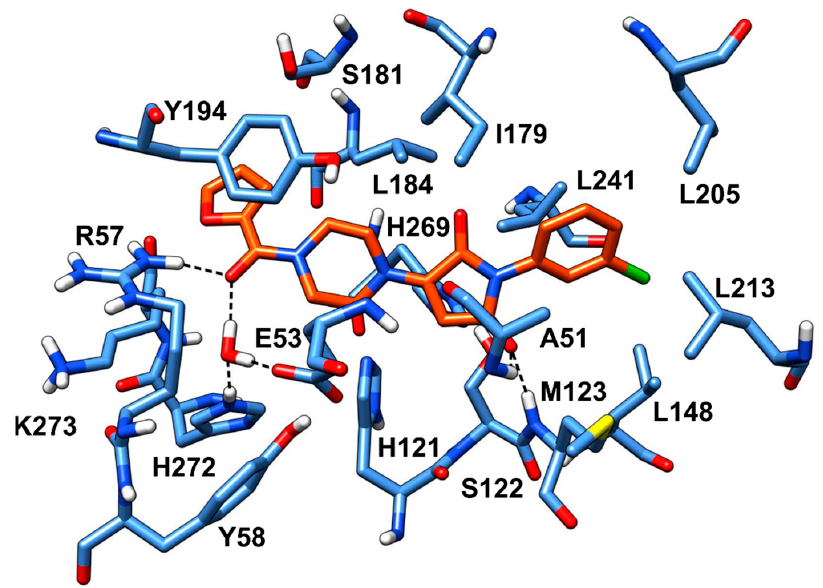
Figure 4. Minimized average structure of VS2 within MAGL binding site.